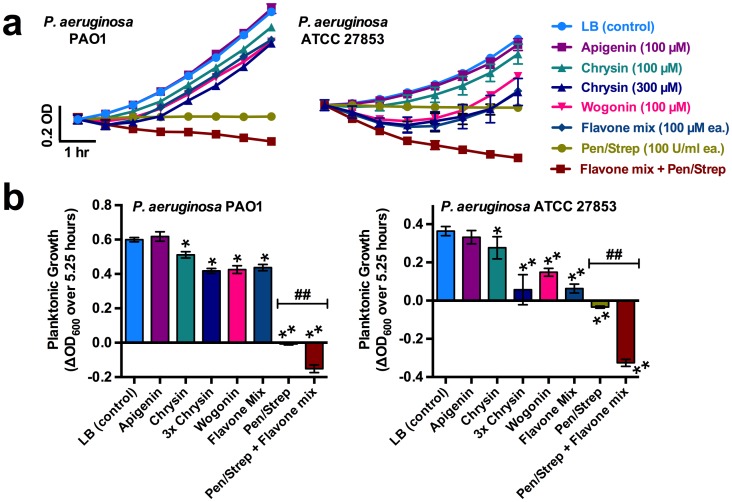
Synergistic anti-bacterial effects of flavones in combination with antibiotics.(A) Planktonic growth traces (OD600) of 2 strains of P. aeruginosa (PAO1 and ATCC 27853) under the indicated conditions. Note reduction of OD600 in the presence of penicillin/streptomycin plus flavone mixture (apigenin, chrysin, wogonin; 100 μM each). (B) Bar graphs showing ΔOD600 over 5.25 hrs from A (n = 4 experiments for each condition). Asterisks denote significance vs. control (LB only; one-way ANOVA, Dunnett’s post-test; * = p <0.05, ** = p <0.01); ## indicates p <0.01 between bracketed bars (one-way ANOVA, Bonferonni post-test).